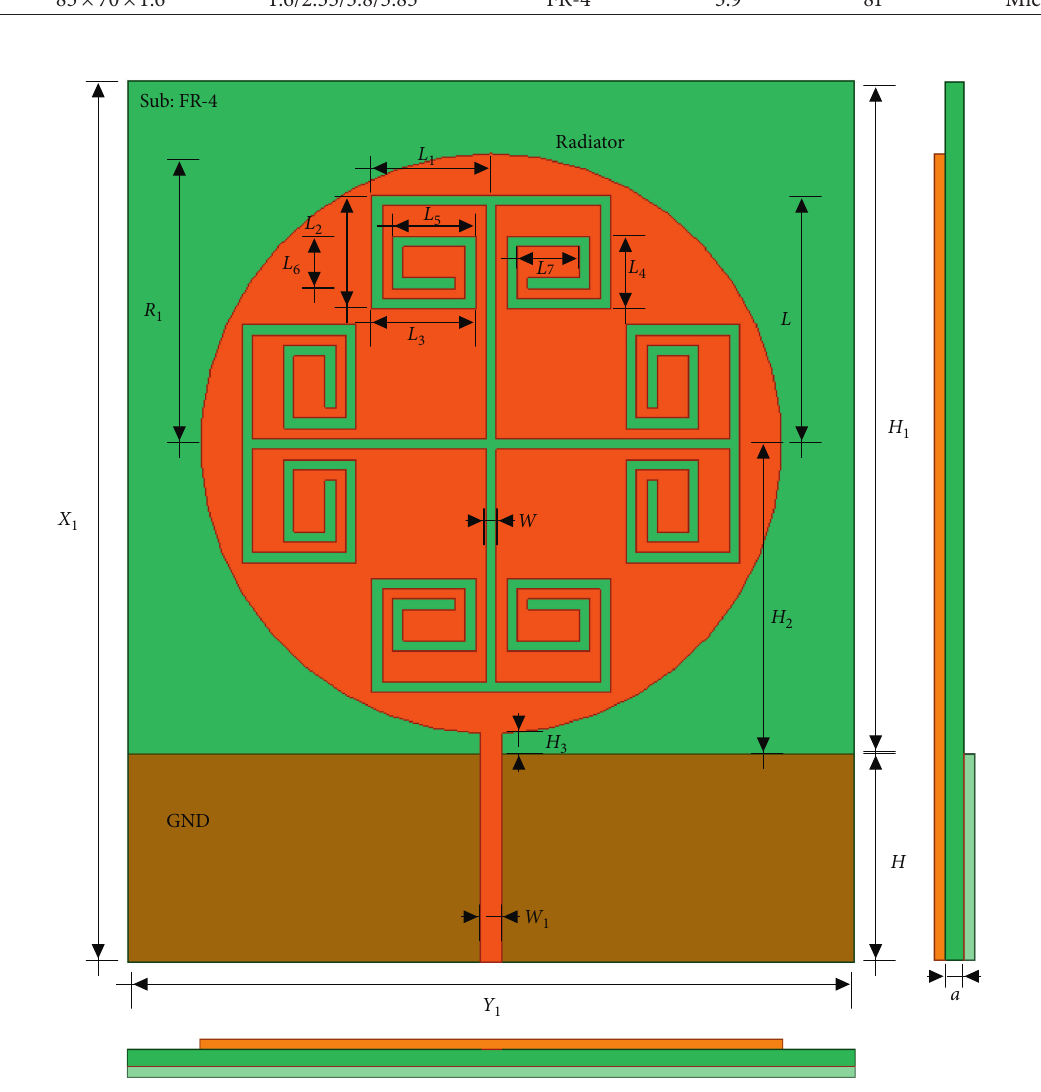
Figure 1: Layout of the proposed Table 2: Dimensions of the proposed antenna.